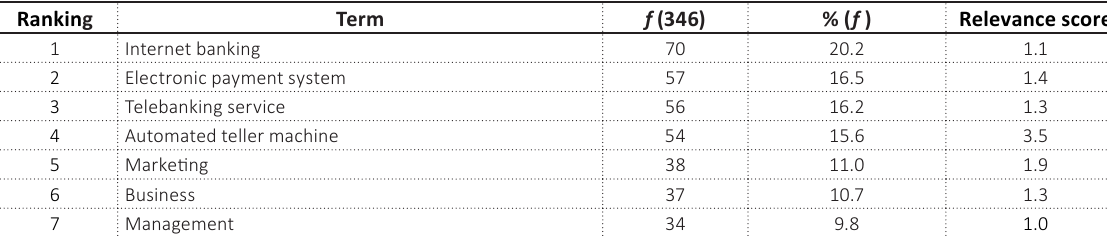
Table 4. Keyword relevance based on Google Scholar outputs